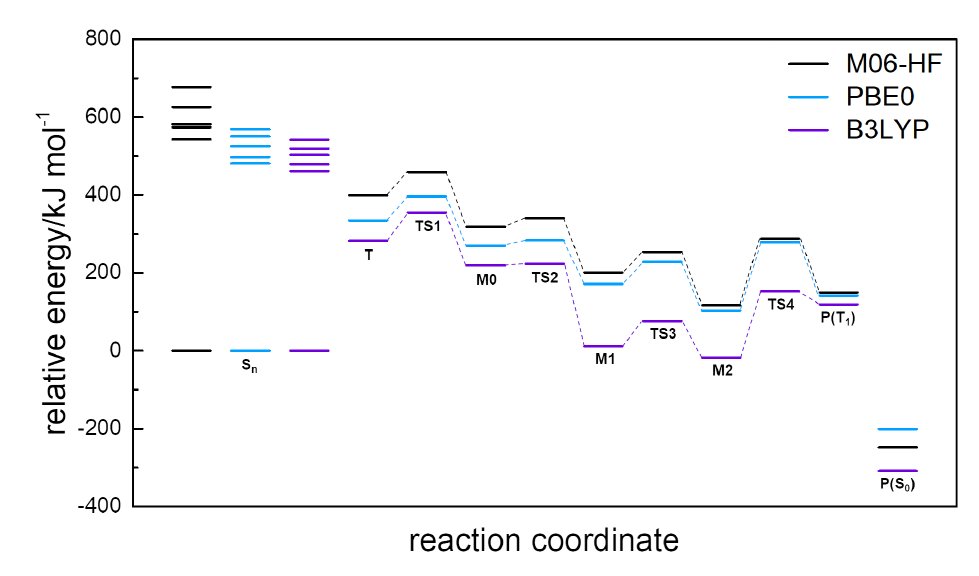
Figure 7. Relative energy profile for ATZ photoreaction, considering zero-point harmonic energy.